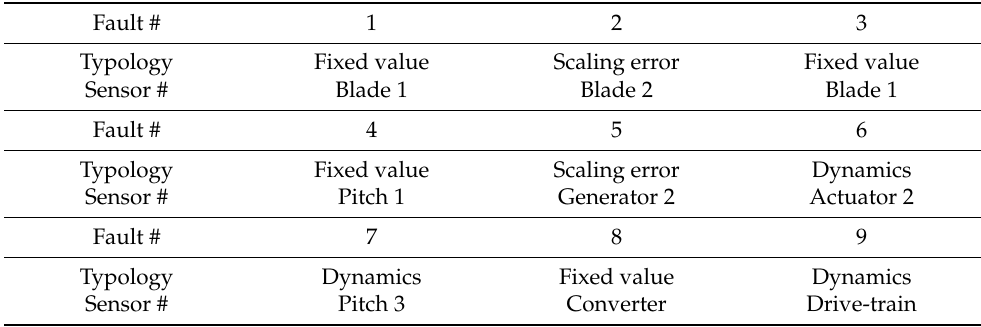
Table 2. Turbine benchmark model fault